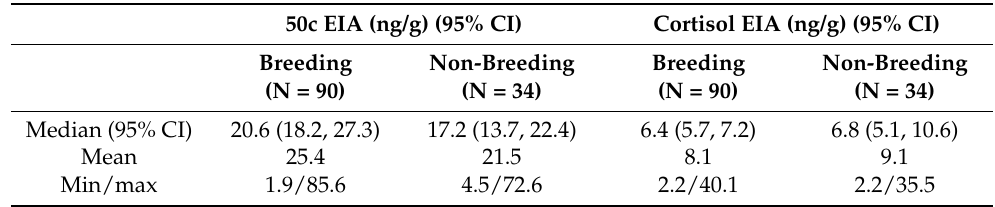
Table A6. FCM (faecal cortisol metabolites) values measured by the 50c and the cortisol EIAs (enzyme immunoassays) for the control koalas during breeding and non-breeding seasons on the first collection day.